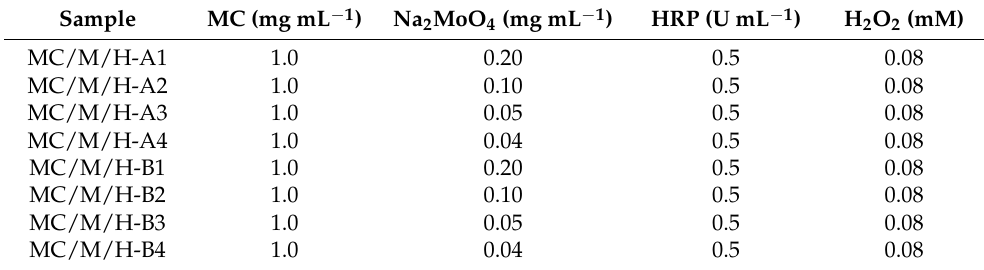
Table 2. Composition of multiple-crosslinked nanogels with Na 2 MoO 4 and